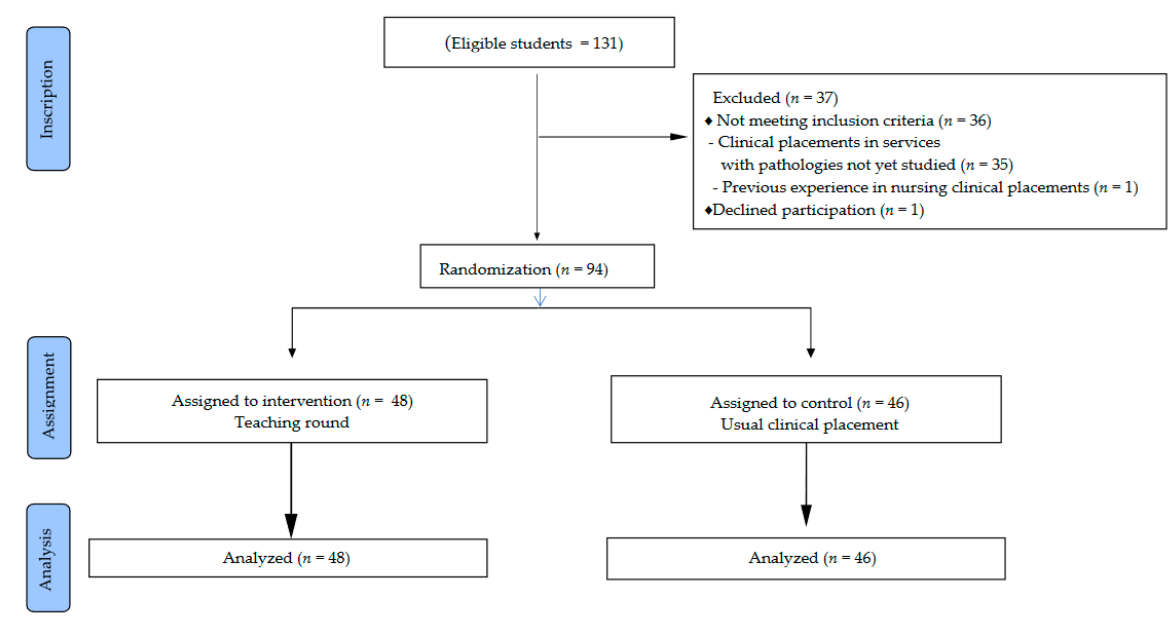
Figure 1. Flow diagram of the students.